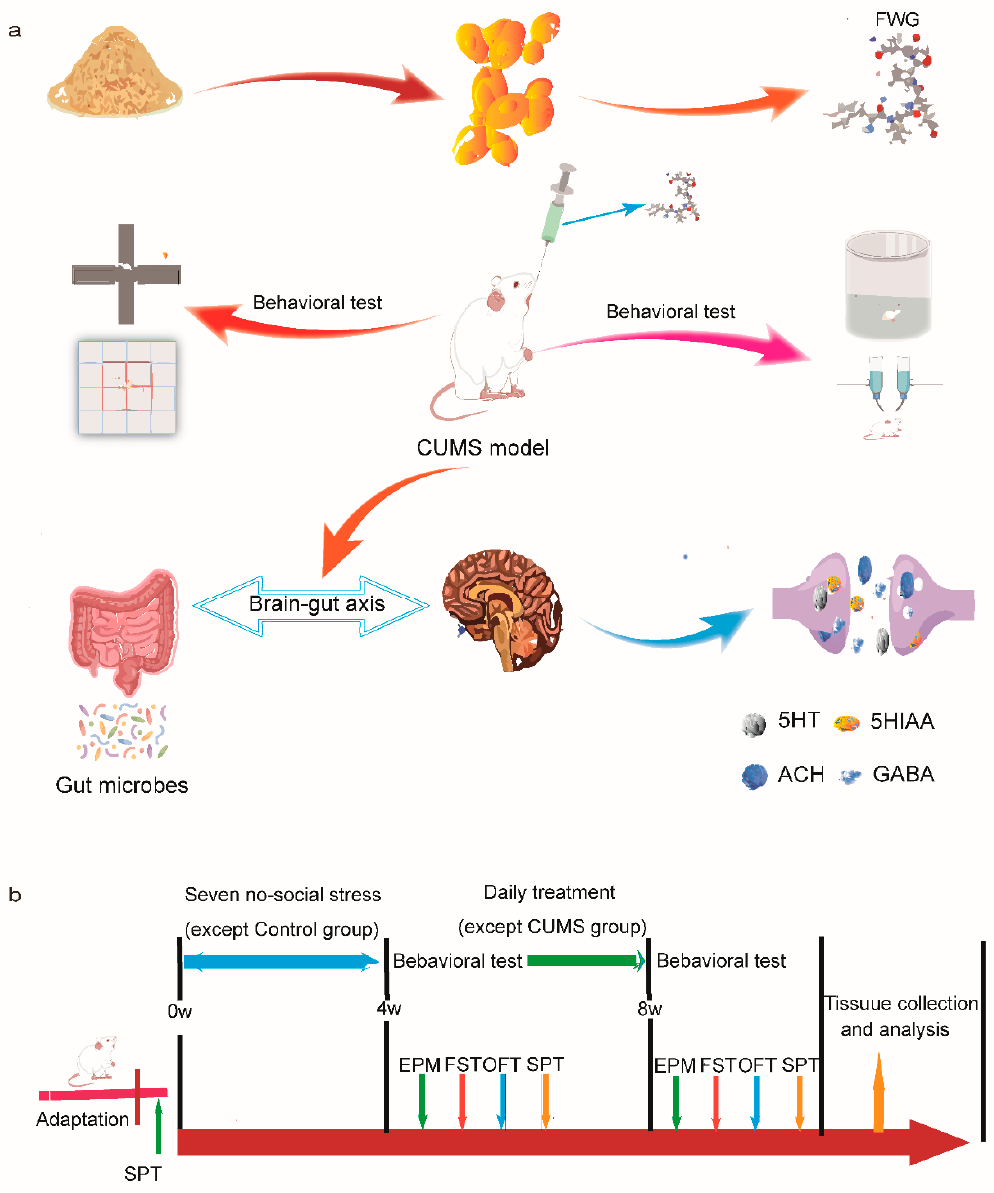
Figure 1. Experimental program overall design diagram ( a ) Schematic illustration for rational design of preparation of FWG for treatment of depression in rat by modulating gut microbes (Drawn by Figdraw). ( b ) Schematic diagram of a phased protocol for animal experiments. (FWG, Fermented wheat germs; CUMS, chronic unpredictable mild stress; 5-HT, 5-hydroxytryptamine; 5-HIAA, 5- hydroxyindoleacetic acid; ACH, acetylcholine; GABA, γ -aminobutyric acid; SPT, sucrose preference test; EMP, elevated plus maze experiment; FST, Forced swimming experiment; OFT, open field test.).